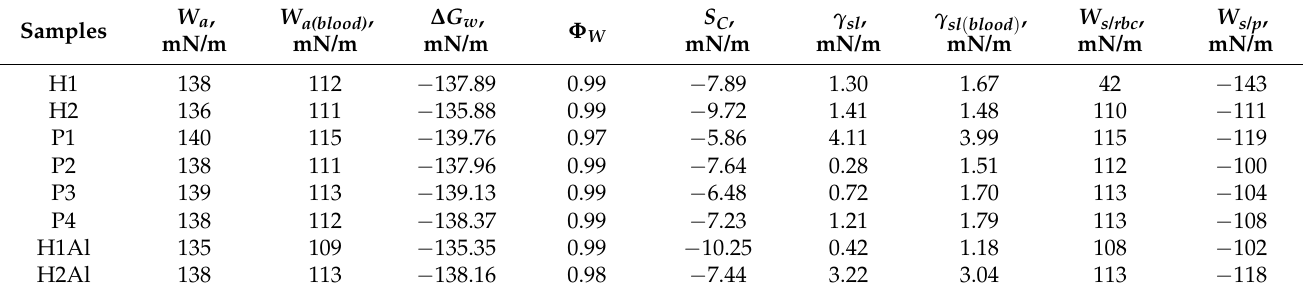
Table 4. The values of work of adhesion, free energy of hydration, Girifalco–Good’s interaction parameter, interfacial tension corresponding to water and to blood, and spreading parameter of dried